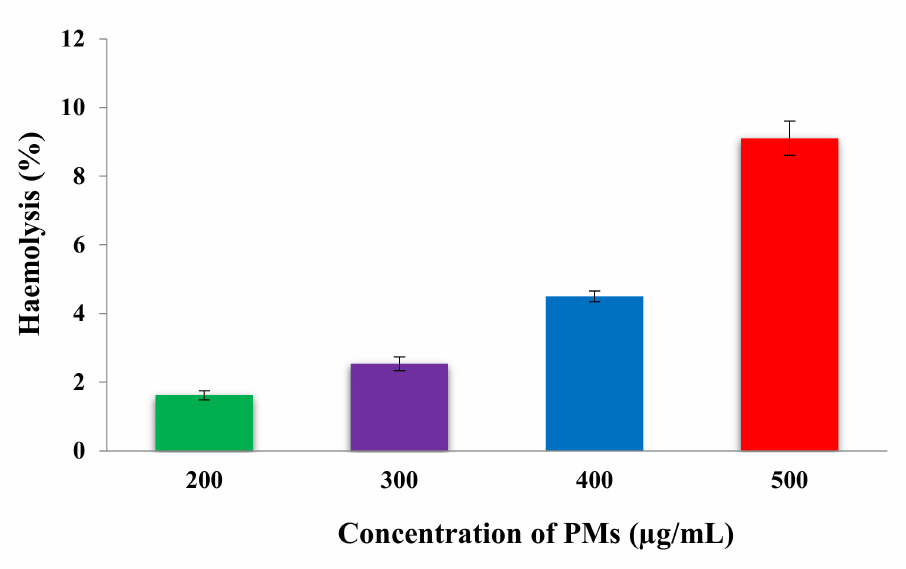
Figure 4. In vitro hemolysis evolution as a function of the concentration of